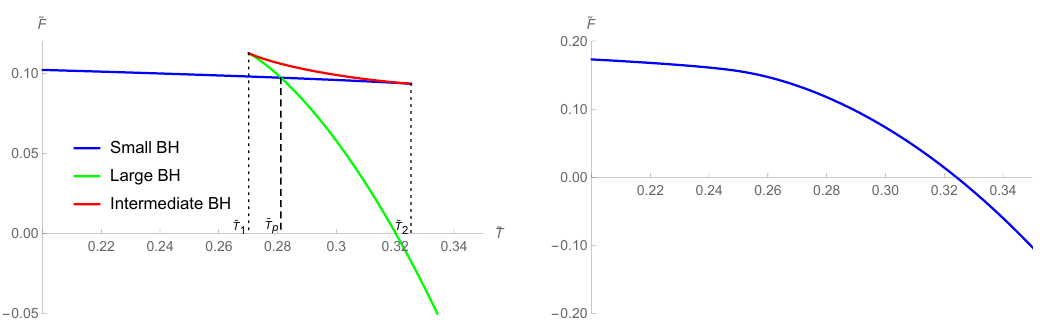
˜ T ˜ T < ˜ T 1 < 2 , and a first-order phase